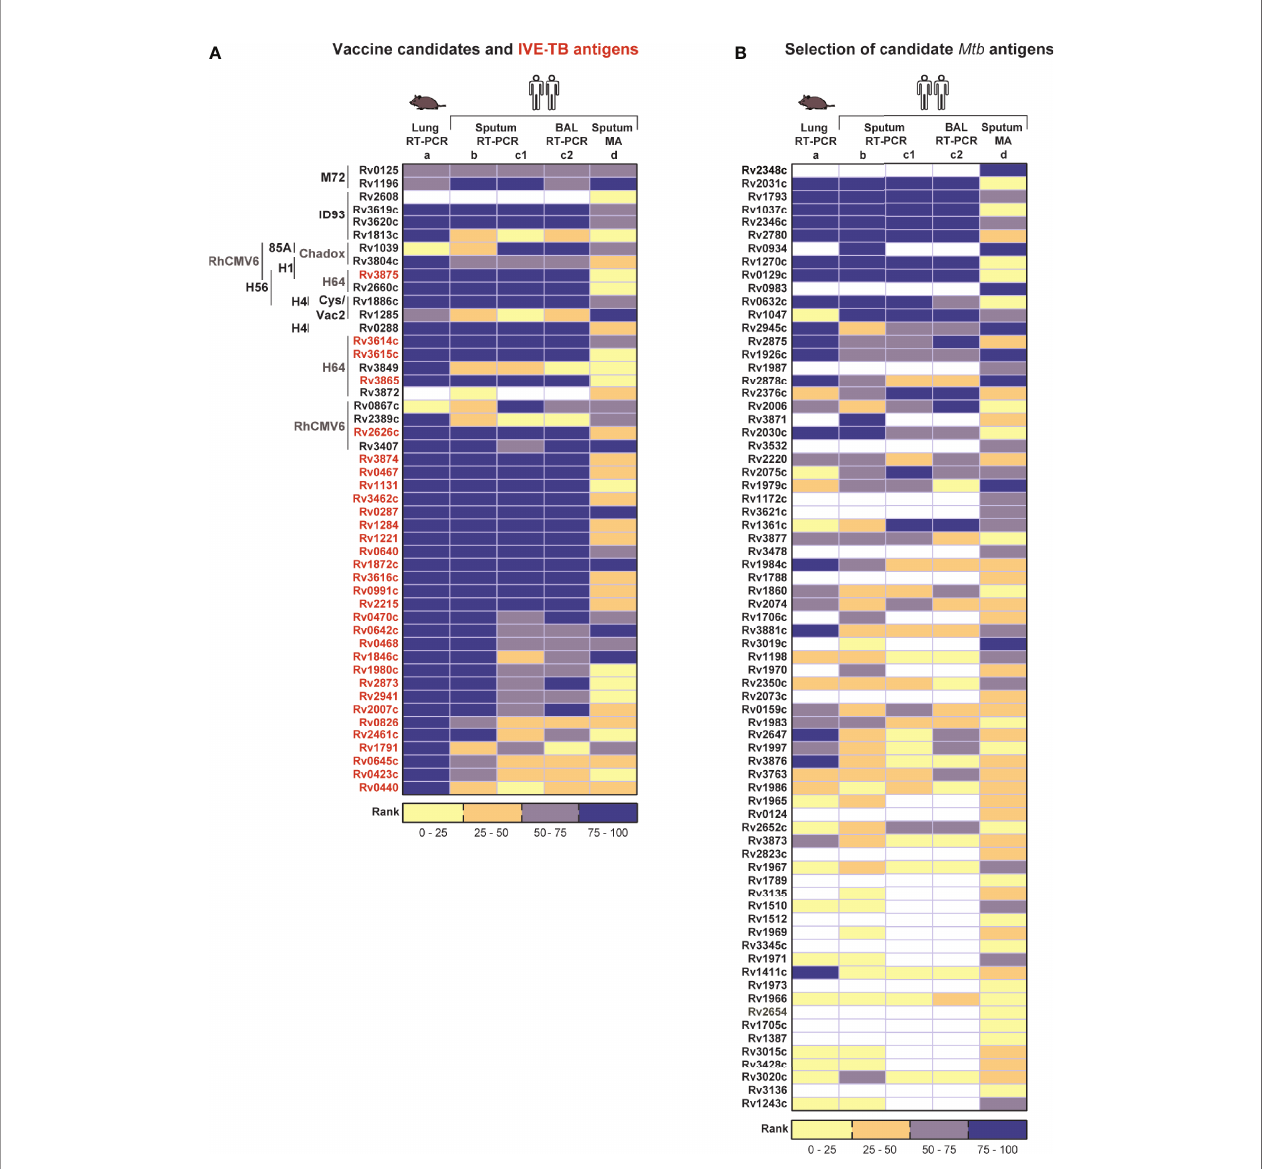
FIGURE 3 | Expression of Mtb genes encoding candidate TB vaccine antigens and IVE-TB antigens across datasets. The median expression level of Mtb genes encoding a selection of the most promising Mtb antigens previously identi fi ed was interrogated from published (8, 11, 12, 15) lung Mtb infection-centred transcriptomic datasets. Each column represents the relative expression rank calculated obtained from our analysis within each dataset, as indicated in the boxes by numbers. Source data are provided in Supplementary Table 1 (A) Proteins constituting clinical or late preclinical subunit TB vaccine candidates (n=22) as well as IVE-TB antigens (font color red, n=30) previously identi fi ed. On the left of each antigen is indicated the name of the vaccine candidates of which they are part (font colors in black or grey differentiate candidates in clinical and pre-clinical studies, respectively). (B) Expression ranks of genes used in commercial diagnostics (Rv2348c, font color grey) and genes encoding Mtb proteins described as promising antigens (n=70) by at least two previous independent studies other than the IVE-TB approach (7, 23). Undetermined expression ranks are color coded in white. Datasets are listed from left to right as in Figure 2 (see legend Figure 2